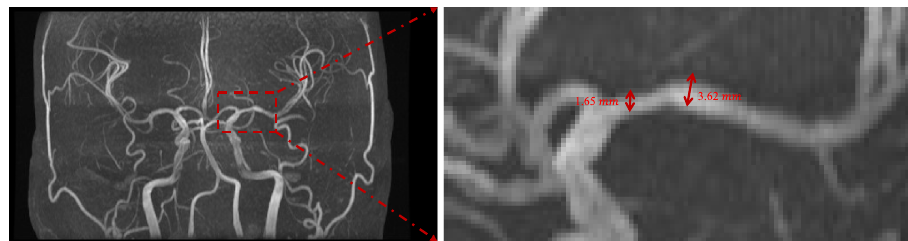
Fig. 10 MR medical image for patient-specific cerebral arter- ies, case 2, the circled area has a 55% area reduction stenosis